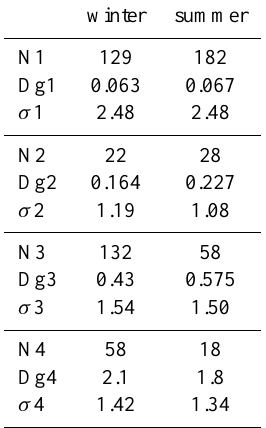
Table 2. Parameters for fitted log-normal aerosol number size dis- tributions, where Nx is the number concentration (cm − 3 ), Dgx the geometric diameter (µm) and σ x the standard deviation for the dif- ferent modes and